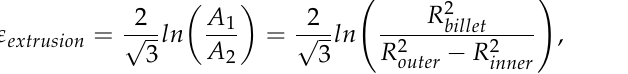
where A 1 is the area of the initial cross-section of the sample, A 2 denotes the cross-section after extrusion, R billet means the radius of the initial billet, and R outer and R inner are the outer and inner radii of the produced tube, respectively. By applying Equation (1) to the CSET form used in our experiment, the equivalent strain of 0.6 can be estimated using the parameters from Figure 1 ( R billet = 5.5 mm, R outer = 5.5 mm, R inner = 3.5 mm). After the extrusion step, the material goes through two ECAP passes. The equivalent strain for ECAP can be expressed as [1]